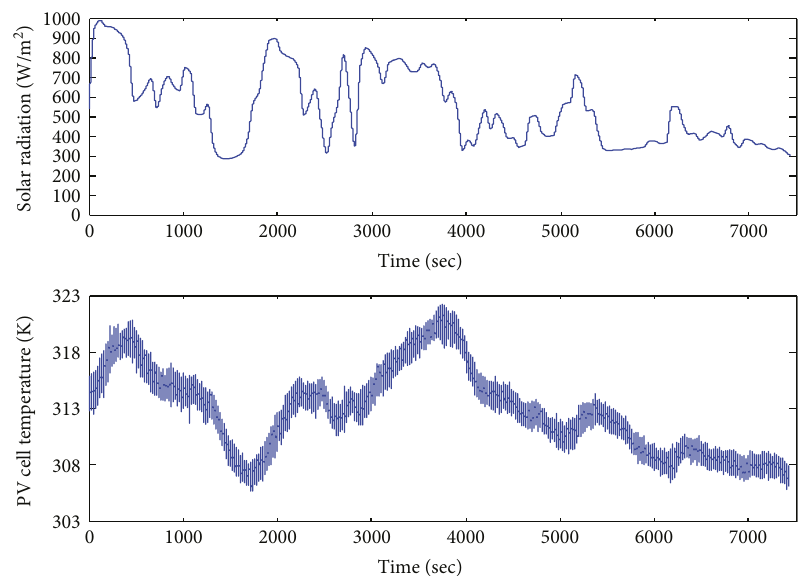
Figure 22: Changing the solar radiation and PV temperature on a cloudy day. From 12:56PM to 3:00PM.